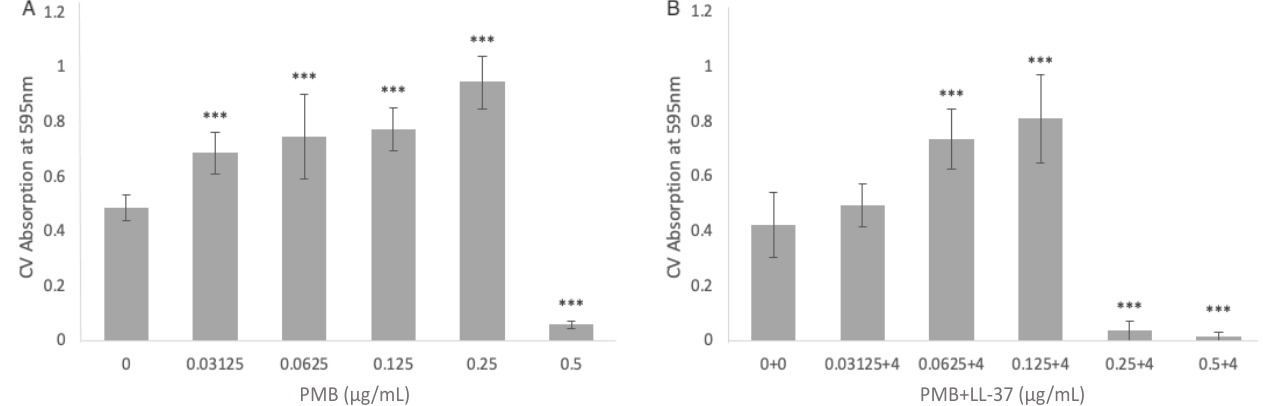
Figure 2. The inhibitory effect of ( A ) PMB alone and ( B ) the combination of PMB + LL-37 on the formation of E. coli MG1655 biofilms. The ability of PMB, alone and in combination with LL-37, to inhibit E. coli MG1655 biofilm growth was evaluated via crystal violet staining. ( A ) The amount of E. coli MG1655 biofilm growth in the presence of single treatments of 0 μ g/mL, 0.03125 μ g/mL, 0.0625 μ g/mL, 0.125 μ g/mL, 0.25 μ g/mL, and 0.5 μ g/mL PMB. ( B ) The amount of E. coli MG1655 biofilm growth in the presence of 0 μ g/mL PMB + 0 μ g/mL LL-37, 0.03125 μ g/mL PMB + 4 μ g/mL LL-37, 0.0625 µ g/mL PMB + 4 µ g/mL LL-37, 0.125 µ g/mL PMB + 4 µ g/mL LL-37, 0.25 µ g/mL PMB + 4 µ g/mL LL-37, and 0.5 µ g/mL PMB+ 4 µ g/mL LL-37 treatments. The biofilm biomass was measured at 595 nm after an incubation of 24 h at 37 ◦ C. The mean background absorbance values were subtracted from the results for the test wells. The analysis of variance (ANOVA) tests (***, p < 0.001) were calculated for the average values from at least two independent experiments. Each experiment included two independent bacterial cultures, with each condition including data from eight wells of a microtiter plate. Standard deviation bars are